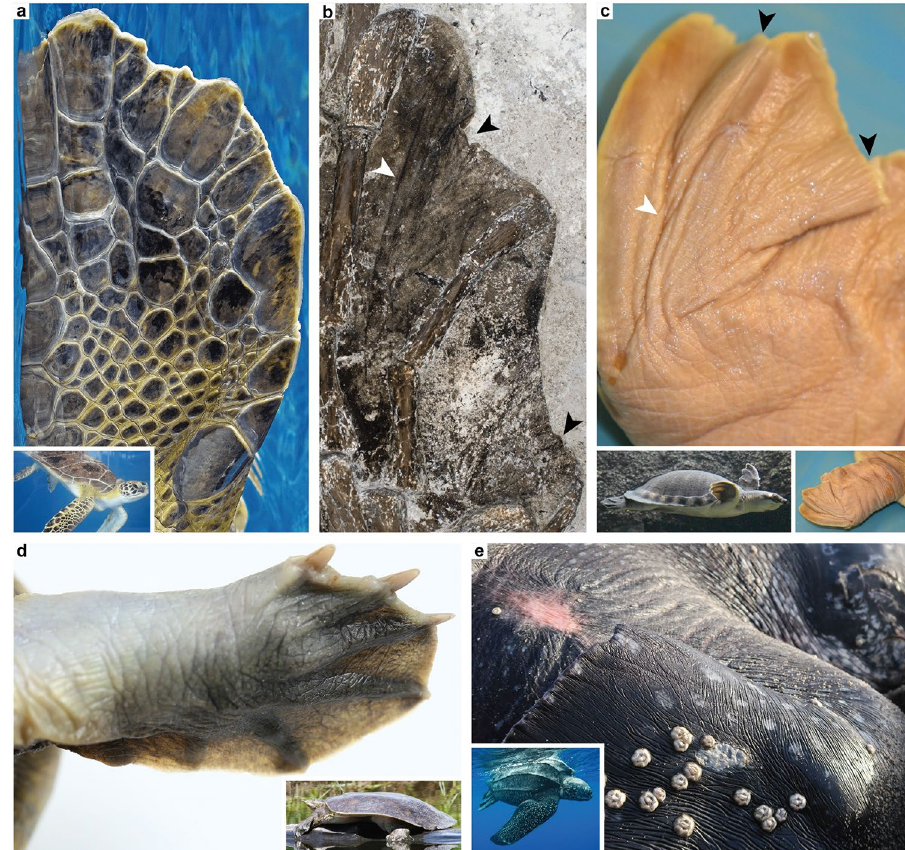
Figure 9. Comparisons of integumental patterns in various turtle paddles and flippers. ( a ) Rear flipper in a green sea turtle, Chelonia mydas , with scale patterns typical of extant cheloniid turtles. Inset, an adult green sea turtle. ( b ) Close-up image of the right rear flipper in DK 807 (compare with c ; note arrowheads of corresponding colour indicating similarities in skin folds between the fossil and extant turtle flippers). ( c ) Fore- paddle in a modern pig-nosed turtle, Carettochelys insculpta (photo: Herpetology/Senckenberg Dresden). Note soft, scaleless skin with multiple folds. Inset, a pig-nosed turtle. ( d ) Scaleless manus of an Asiatic softshell turtle, Amyda cartilaginea (photo: dwi putra stoc/shutterstock.com). Inset, spiny softshell turtle, Apalone spinifera (photo: Ken Sturm/U.S. Fish and Wildlife Services/Public Domain). ( e ) Front flipper in an adult leatherback turtle, Dermochelys coriacea (photo: William Farah/shutterstock.com). Note leathery skin without scales. Inset, a swimming leatherback turtle (photo: NOAA Fisheries/Public